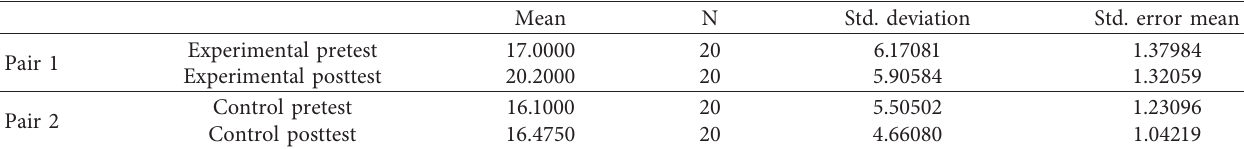
Table 6: Results of descriptive statistics (control vs. experimental